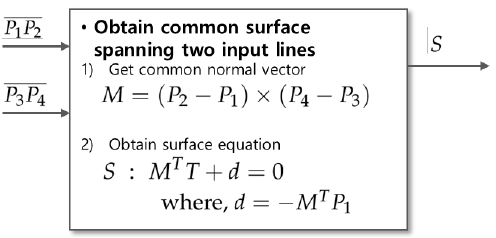
Figure A2. Obtaining the nearest point between the two given lines.